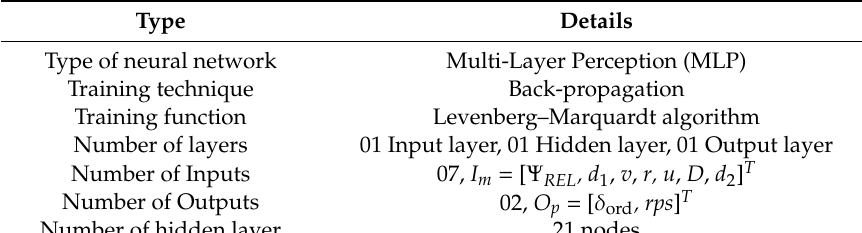
Table 3. The parameters of the structure of the neural network.